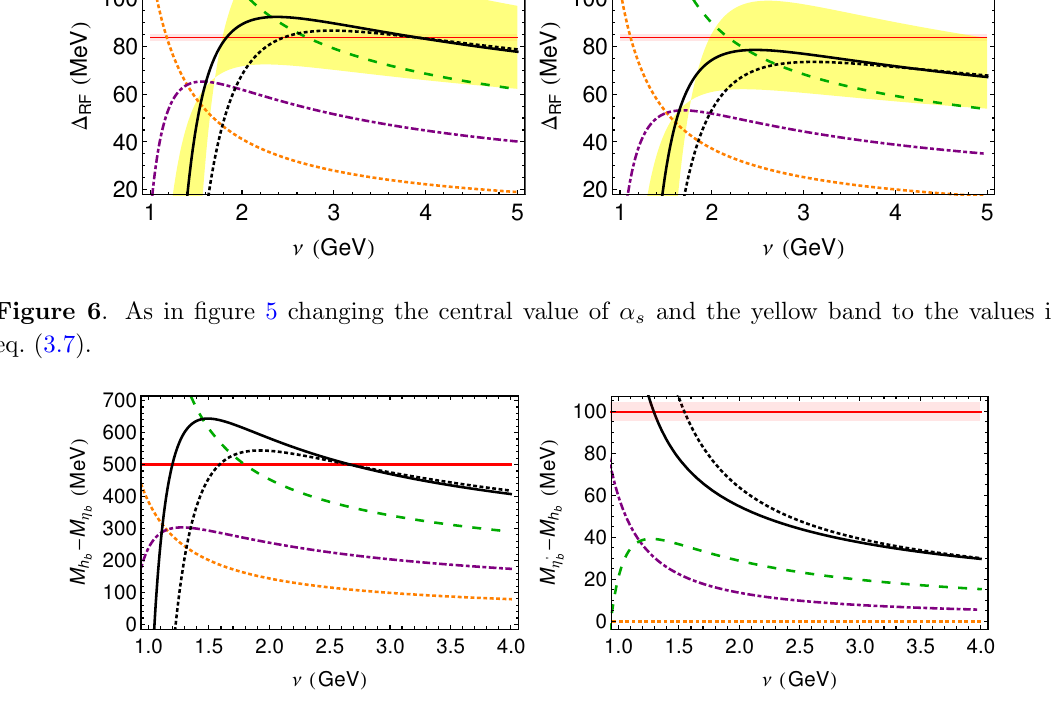
Figure 7 . Plots for n = 2 bottomonium states. The red line is experimental value. Orange dotted, purple dot-dashed and green long-dashed are the LO-NNLO contributions respectively. Solid black line is the N 3 LO, and the dotted black line the N 3 LO without (cid:14)E US Right panel: plot of M (cid:0) M h (cid:17) 0 b b